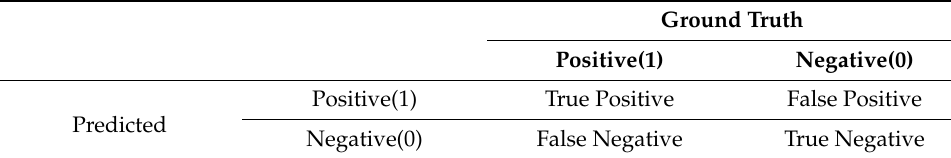
Table 2. The classification confusion